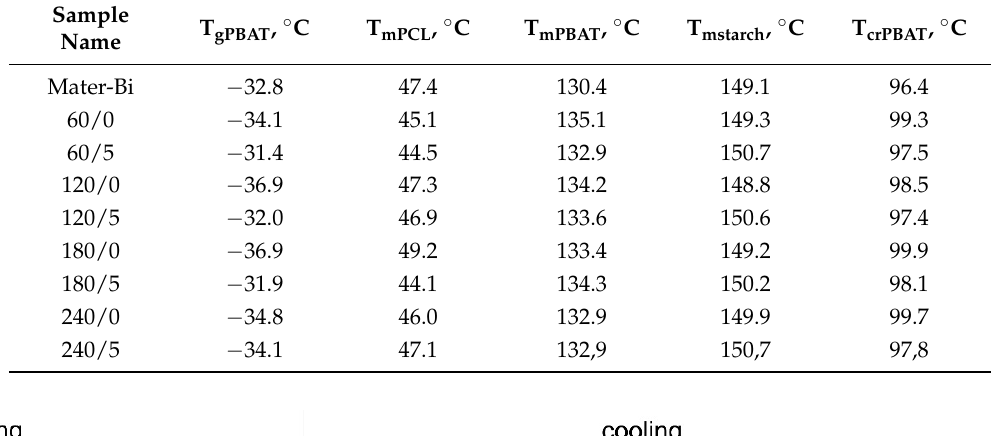
Table 6. Values of phase transition temperatures obtained for Mater-Bi and its composites.